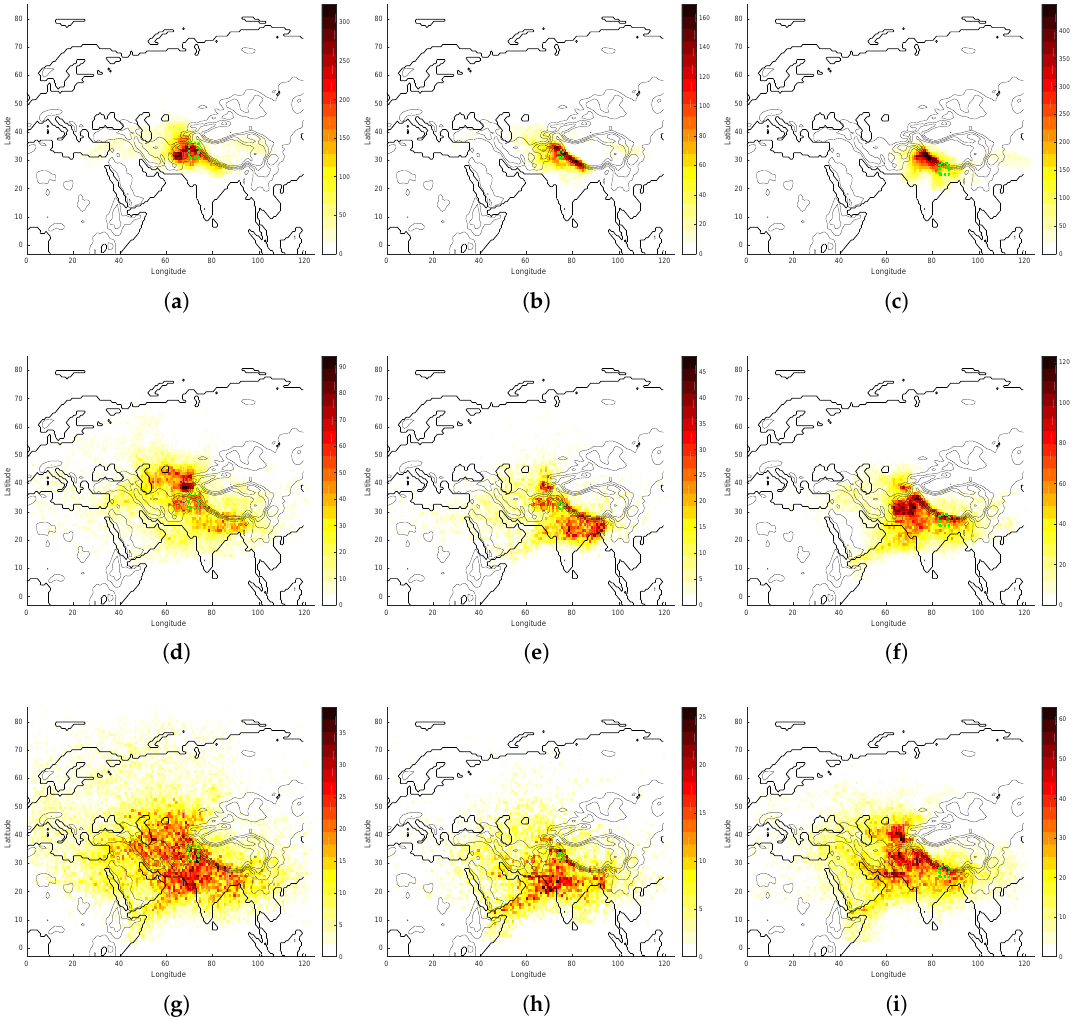
Figure 16. For the 20 strongest precipitation events for each region of interest, the parcel density, for all parcels over each 1 ◦ area, originating from: ( a ) NP , 2 days back in time, along the parcel trajectory; ( b ) U , 2 days back in time, along the parcel trajectory; ( c ) K , 2 days back in time, along the parcel trajectory; ( d ) NP , 6 days back in time, along the parcel trajectory; ( e ) U , 6 days back in time, along the parcel trajectory; ( f ) K , 6 days back in time, along the parcel trajectory; ( g ) NP , 10 days back in time, along the parcel trajectory; ( h ) U , 10 days back in time, along the parcel trajectory; ( i ) K , 10 days back in time, along the parcel trajectory. The area of interest is illustrated by a green dashed